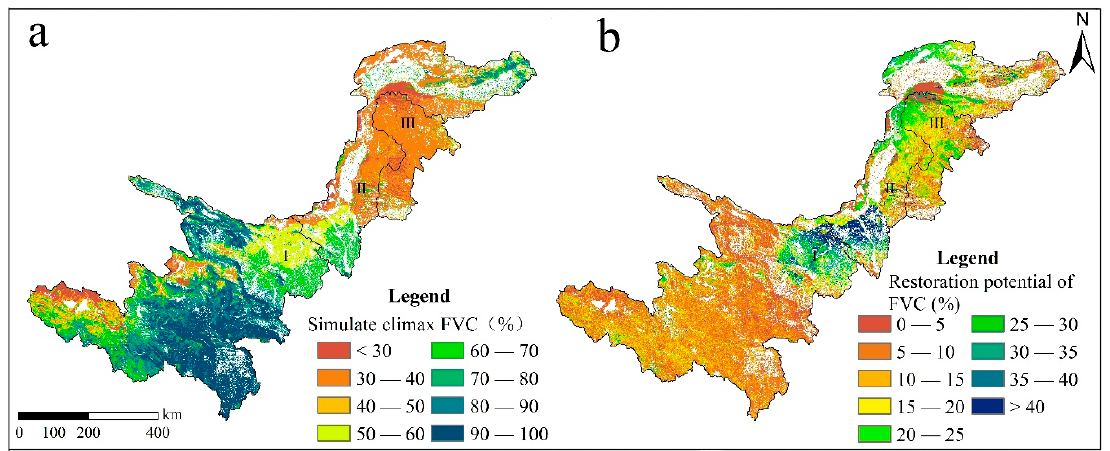
Figure 9. Spatial distributions of the FVC simulated under climax conditions ( a ) and the actual FVC restoration potential ( b